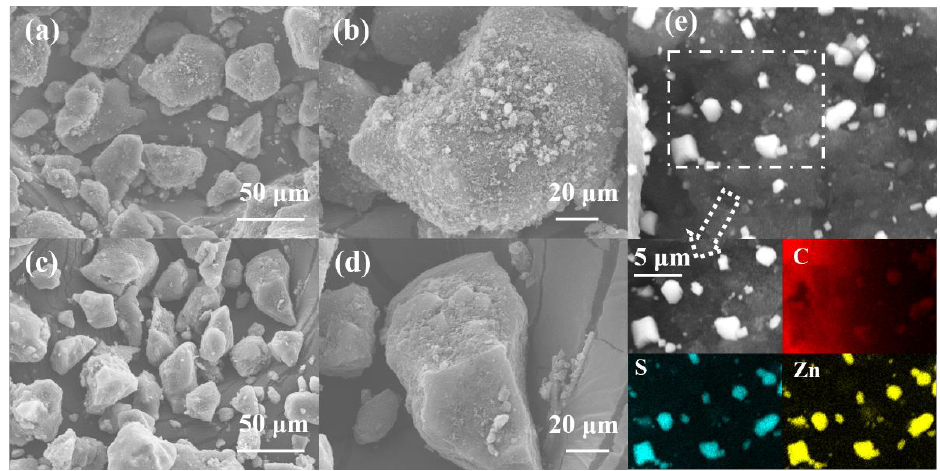
Figure 3. SEM micrographs of ( a , b ) WTC-1; ( c , d ) WTC-2 and ( e ) EDS elemental mapping of WTC-1. The galvanostatic charge/discharge curves of WTC-2 over ten cycles are shown in Figure 4b. The initial specific discharge and charge capacities of the WTC-2 electrode were 633.5 and 457.2 mAh·g −1 , respectively, presenting the initial coulombic efficiency of 72.1%.